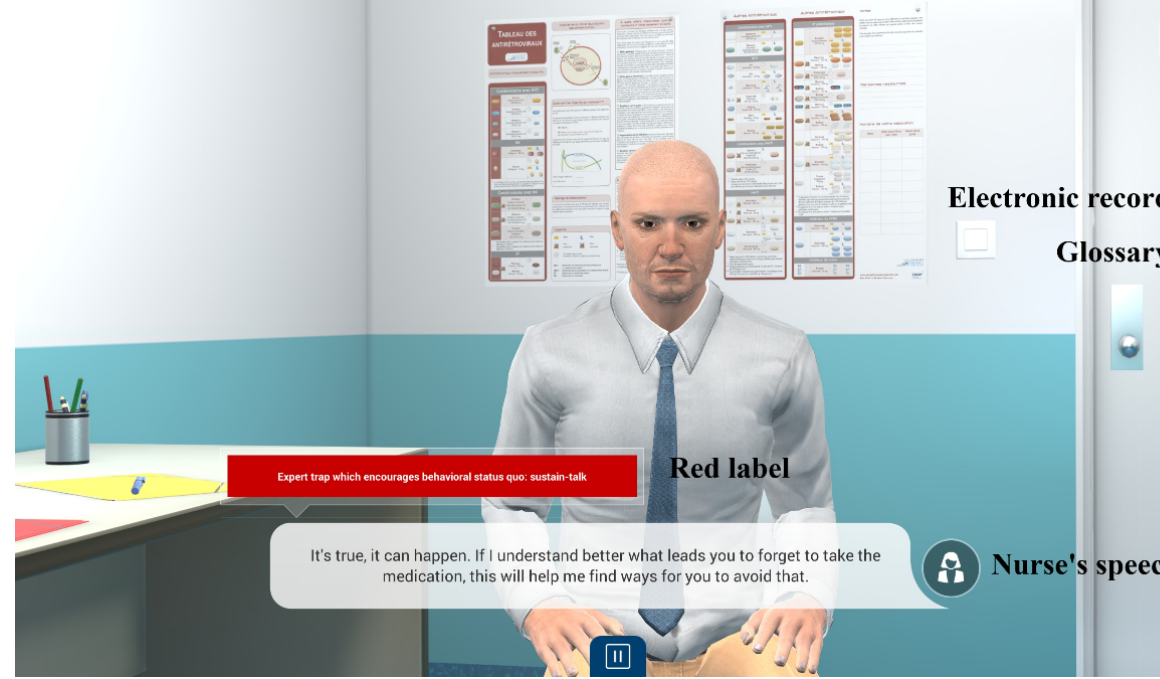
Figure 5. 3D digital content creation